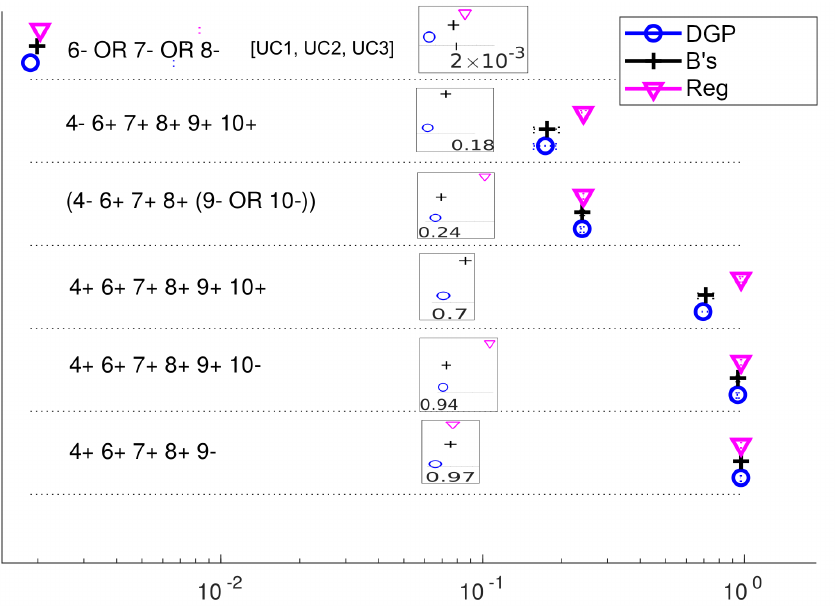
Figure A6. The six distinctive behaviours found for M 4 ( β R − error ; its magnitude, in seconds, in the abscissa) when α R (cid:54) = 1 (axes 3 and 4 are at different extreme positions here). We have used a logarithmic x axis for better distinction between methods in each behaviour, and added some